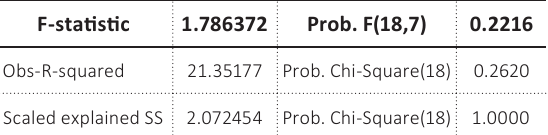
Table 8. Heteroscedasticity test: